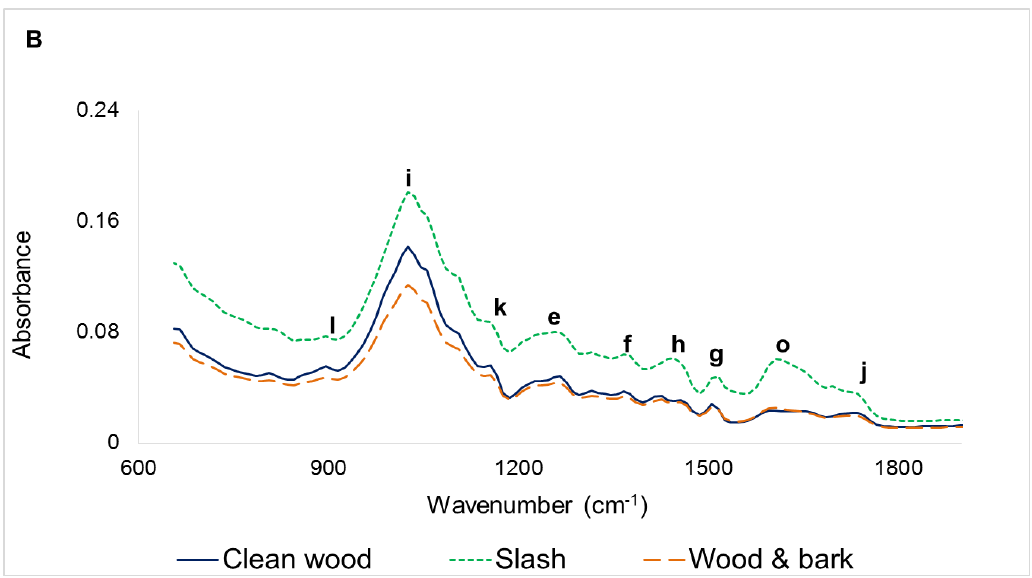
Figure 2. Raw NIR ( A ) and FTIR ( B ) spectra of the different types of forest logging residue.